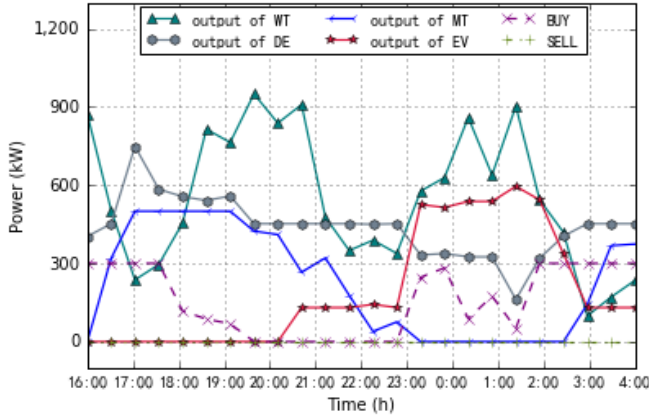
Figure 6. Robust optimization under the worst scenarios.